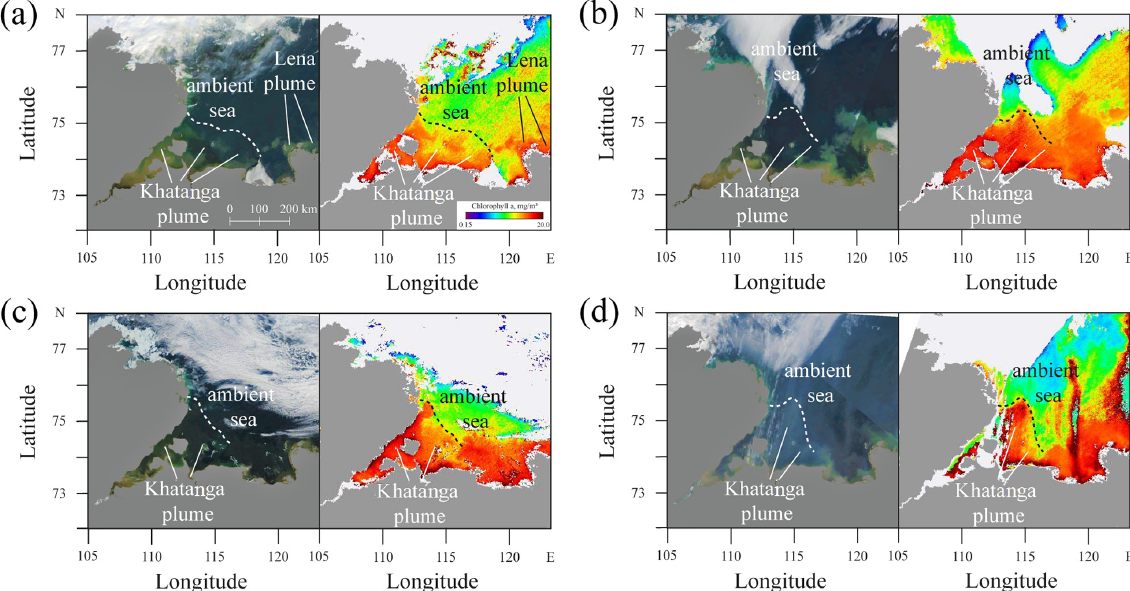
Figure 10. Corrected reflectance (left) and concentration of chlorophyll a (right) from MODIS Terra and MODIS Aqua satellite images of the western part of the Laptev Sea acquired on 8 August 2003 (a) , 13 August 2011 (b) , 8 August 2013 (c) , and 3 August 2019 (d)